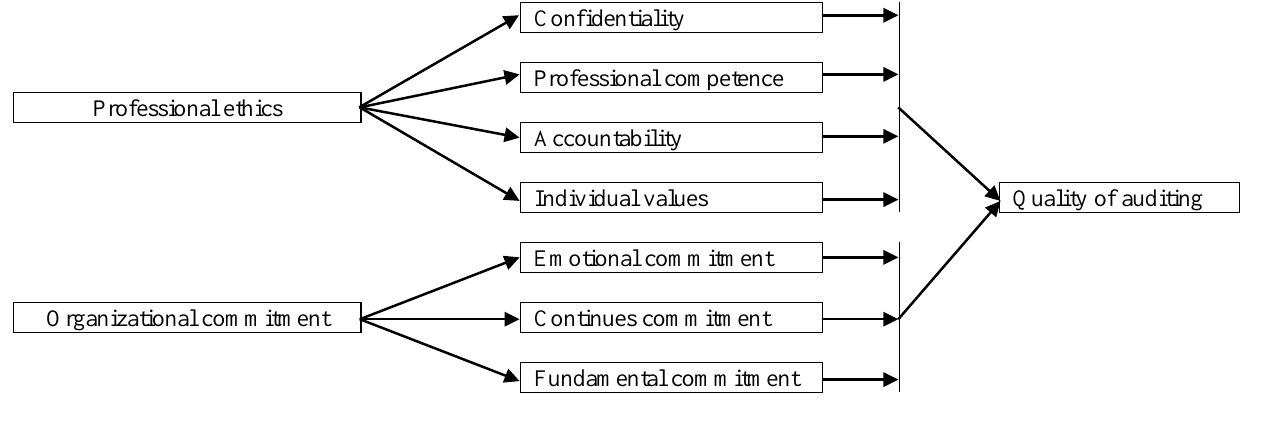
Fig. 1. The structure of the proposed